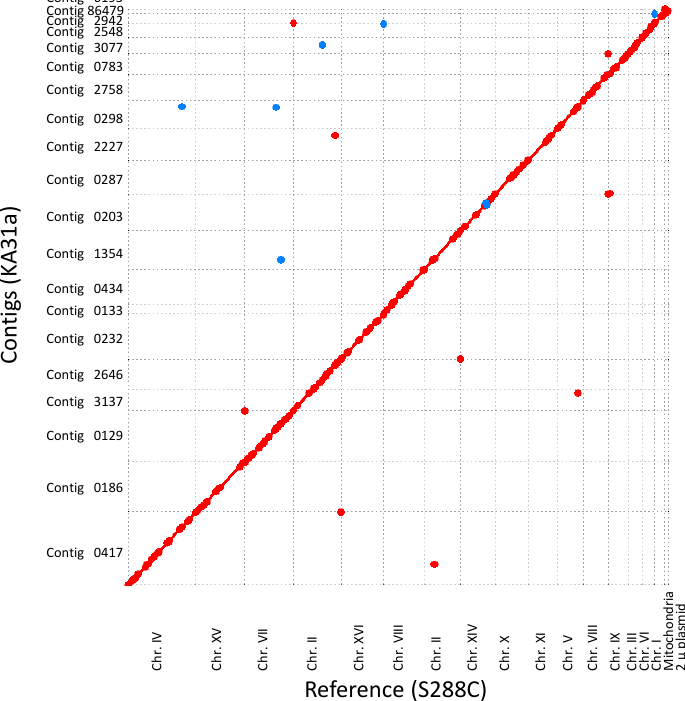
Figure 2. Overall comparison of the genome sequence between strain KA31a and reference strain S288C. Chromosome numbers of the reference strain are shown on the horizontal axis. Contig numbers of strain KA31a are shown on the vertical axis. Conserved regions and complementary regions are shown in red and blue plots, respectively.